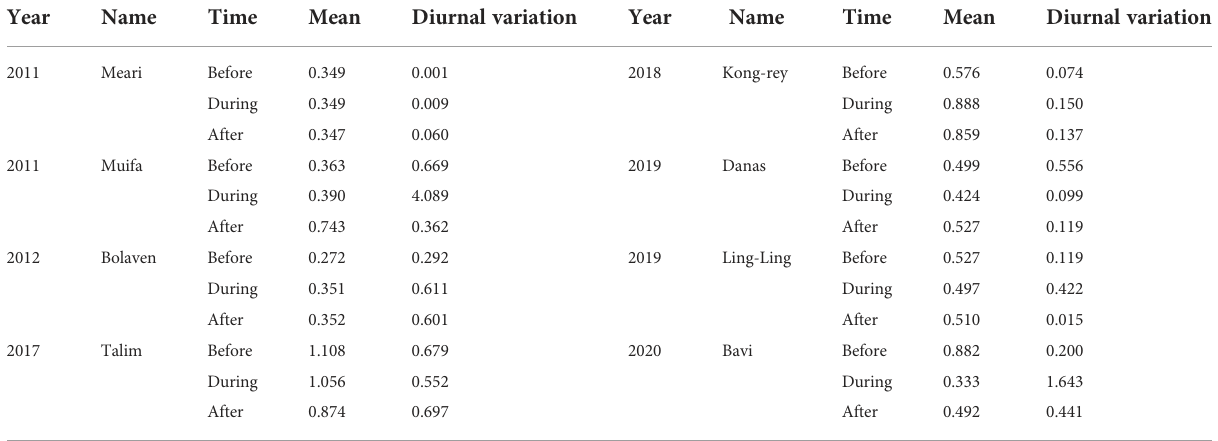
TABLE 3 Results at Offshore Area in GOCI from 2011 to